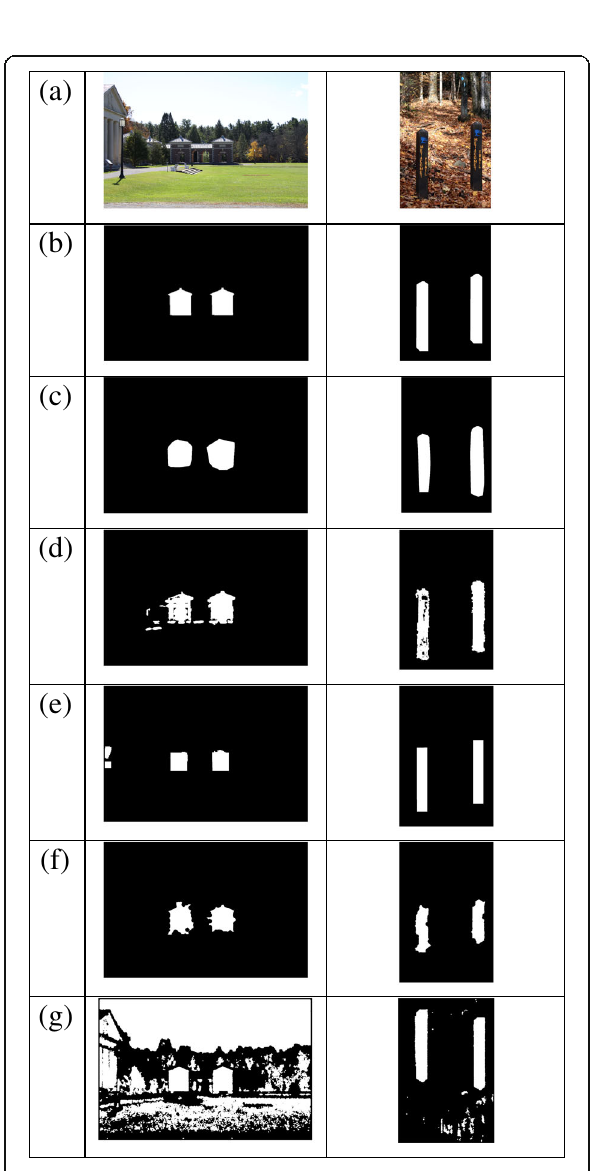
Fig. 9 Detection results under simply copy-move. a Forgery images. b Ground truth. c Our proposed. d Amerini et al. [13]. e Silva et